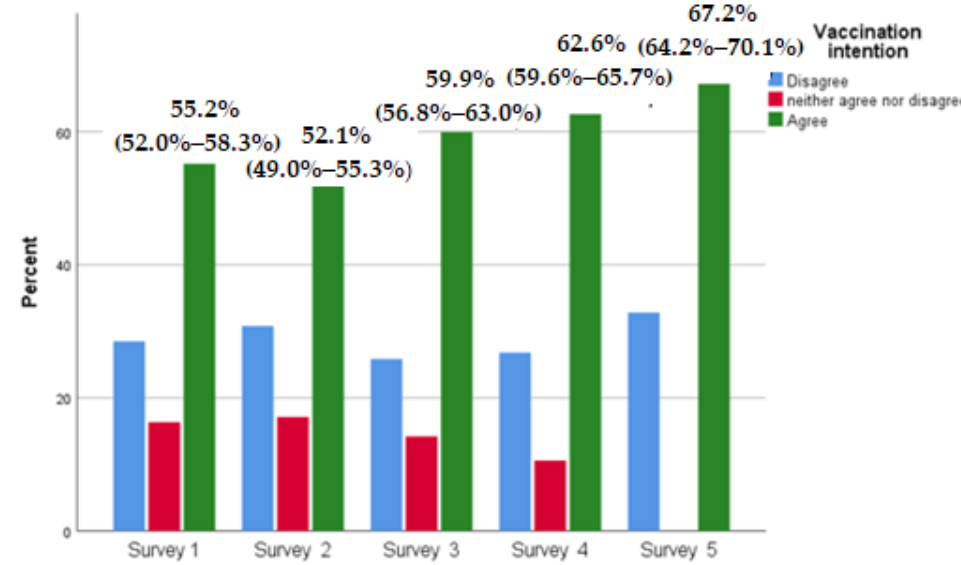
Figure 2. Responses concerning COVID-19 vaccination intention in five surveys implemented among